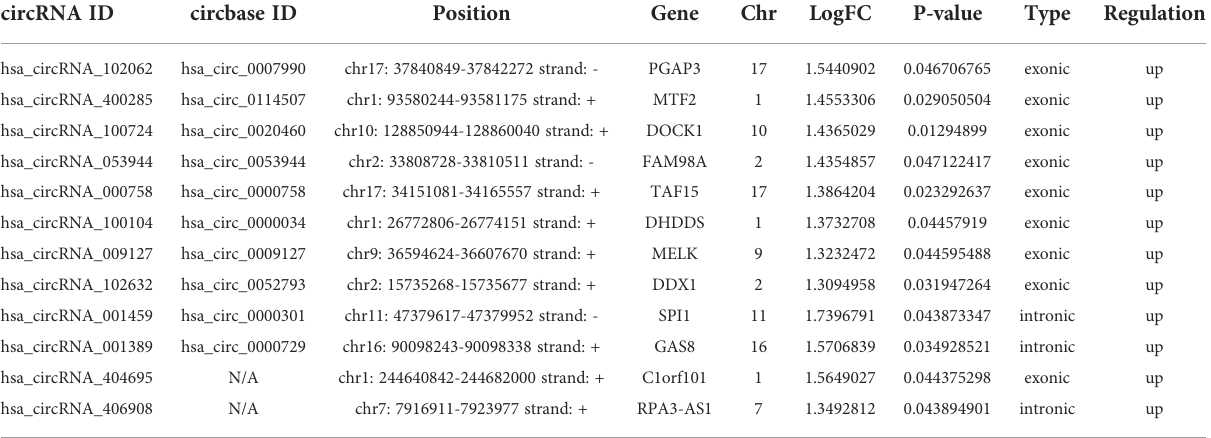
TABLE 2 A total of 12 signi fi cantly differentially expressed peripheral blood circRNAs associated with aneurysm wall enhancement in UIA. circRNA ID